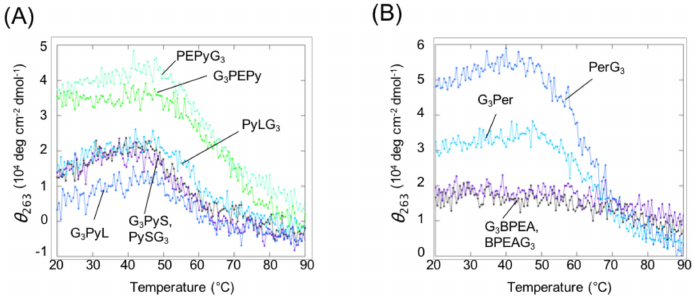
Figure 5. CD melting profiles of 10 µ M VEGF G2T with ( A ) pyrene-conjugated guanin tracts including PySG 3 ( black ), G 3 PyS ( purple ), PyLG 3 ( light blue ), G 3 PyL ( blue ), PEPyG 3 ( pale green ), and G 3 PEPy ( green ), and ( B ) anthracene or perylene derivatives including BPEAG 3 ( black ), G 3 BPEA ( purple ), PerG 3 ( light blue ), and G 3 Per ( blue ). CD melting data were collected by measuring CD intensity at 263 nm in a buffer consisting of 10 mM Tris-HCl (pH 7.5), 8 mM MgCl 2 , and 50 mM